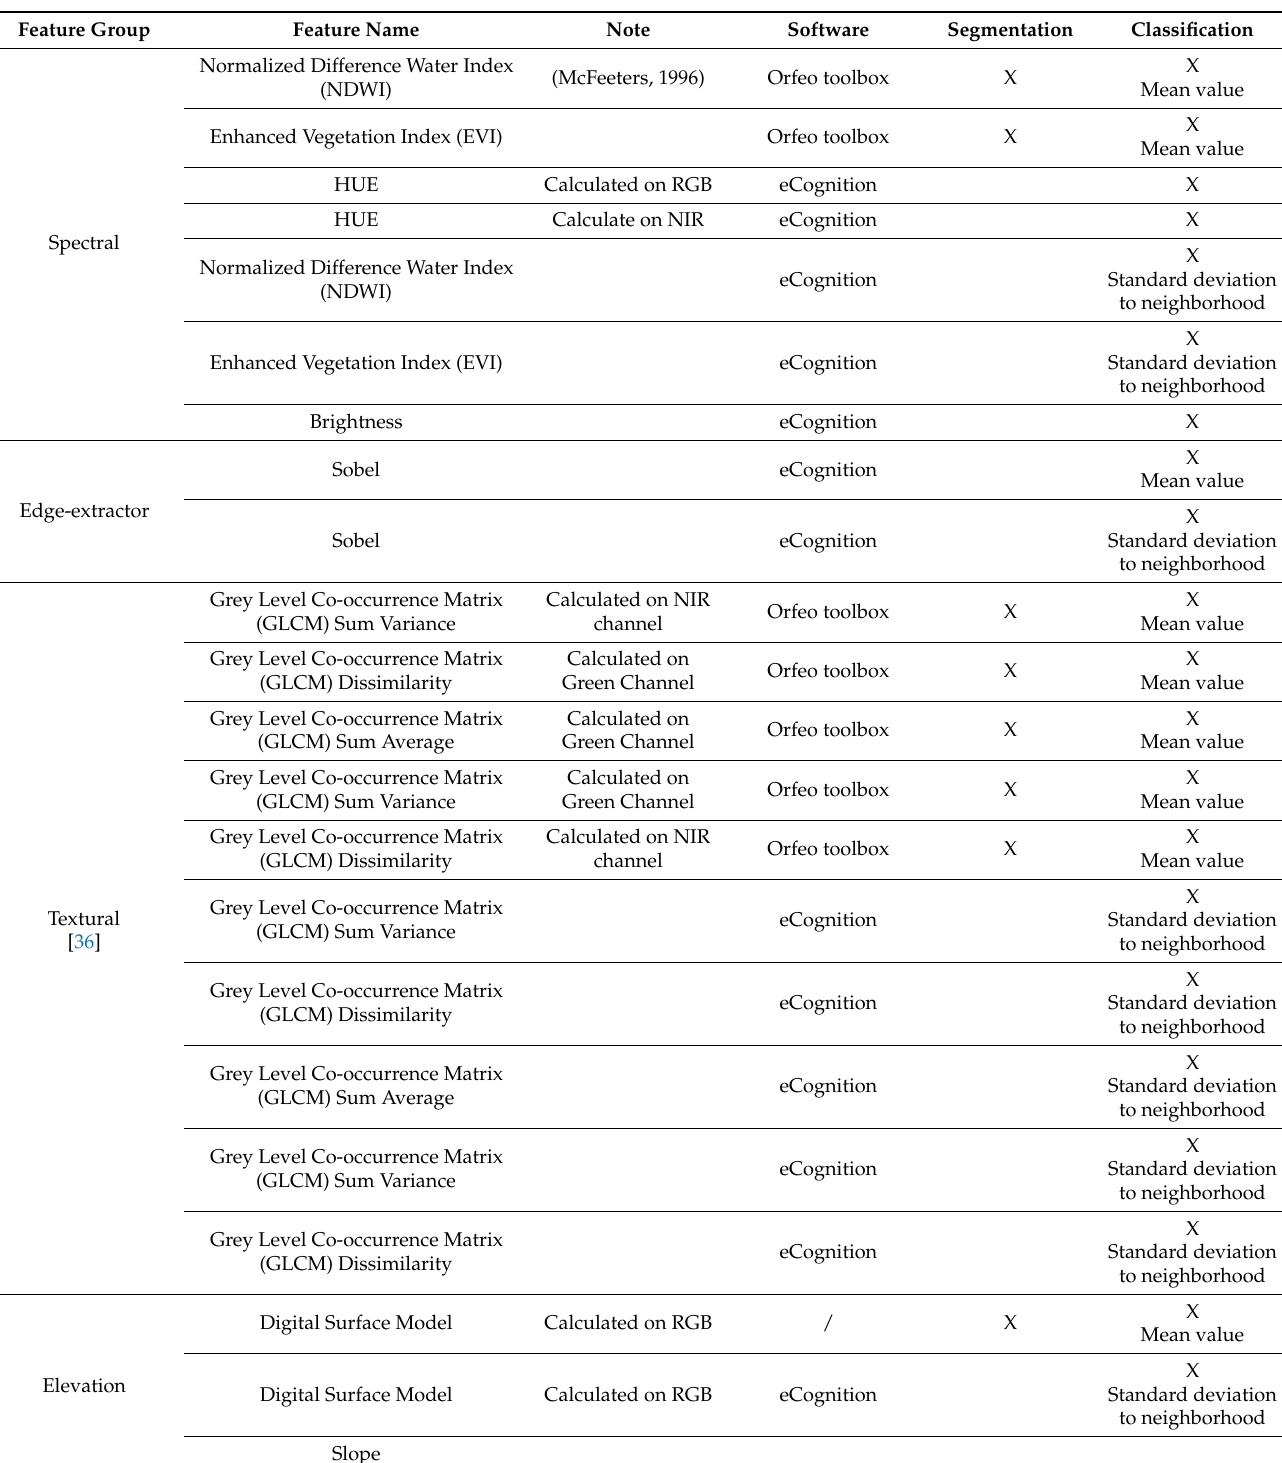
Table A1. Features selected for the segmentation and the